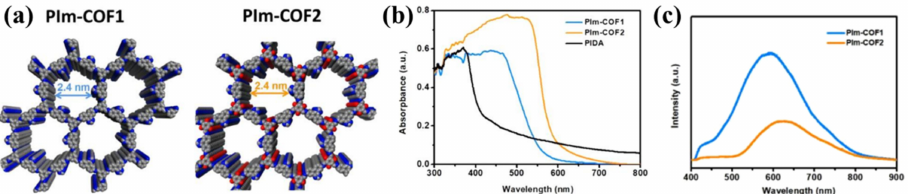
Figure 9. ( a ) Side views of the ideal eclipsed structures of PIm-COF1 (left) and PIm-COF2 (right). ( b ) UV − Vis DSR spectra of PIm-COF1 (blue curve), PIm-COF2 (orange curve), and ligand PIDA (black curve). ( c ) PL intensity of PIm-COFs. Reproduced with permission from Ref. [50]. Copyright: ChemRxiv, 2022.